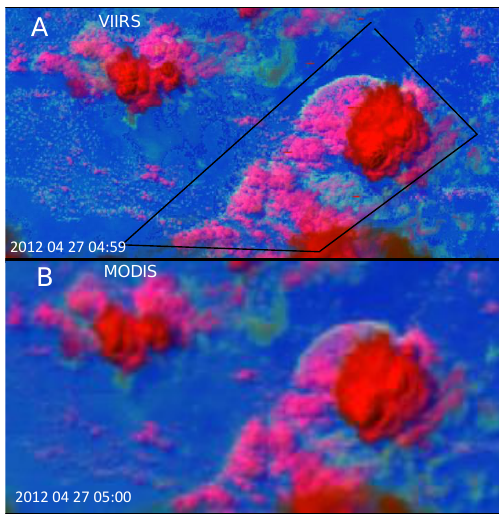
Fig. 18. Pristine oceanic deep convection, as seen by the VIIRS (A) and MODIS (B) overpass on 27 April 2012 over the Banda Sea near Indonesia for an area of 140km × 101km centered at 4.90 ◦ S, 127.72 ◦ E. The color scheme is microphysical RGB. Note the bright rim of the gust front, caused by the shallowness of the clouds there, which in turn causes the cloud drops to be